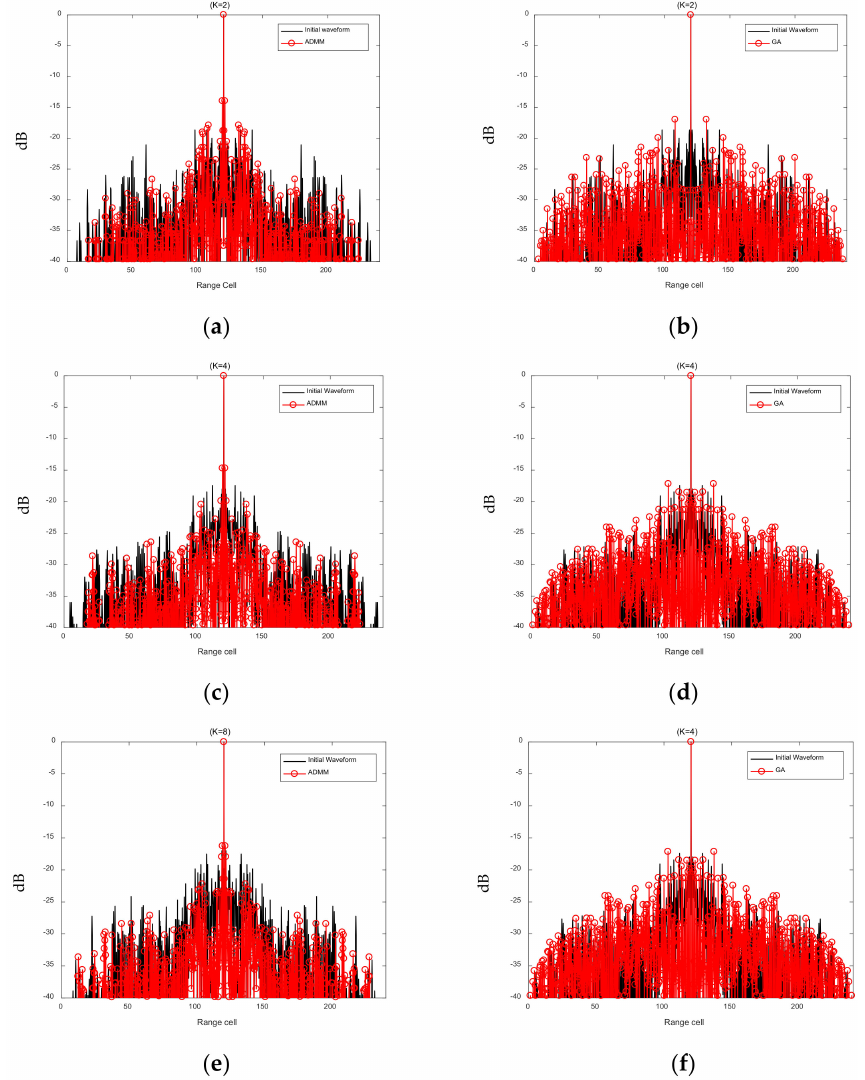
Figure 7. Comparison of FSK-PSK signal AF before and after optimization. ( a ) LSW-ADMM op- timization ( K = 2). ( b ) GA optimization ( K = 2). ( c ) LSW-ADMM optimization ( K = 4). ( d ) GA optimization ( K = 4). ( e ) LSW-ADMM optimization ( K = 8). ( f ) GA optimization ( K =